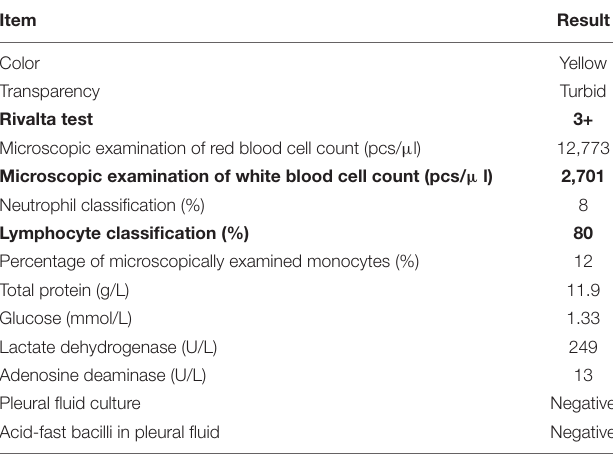
TABLE 2 | Results of the patient’s pleural fluid examinations on